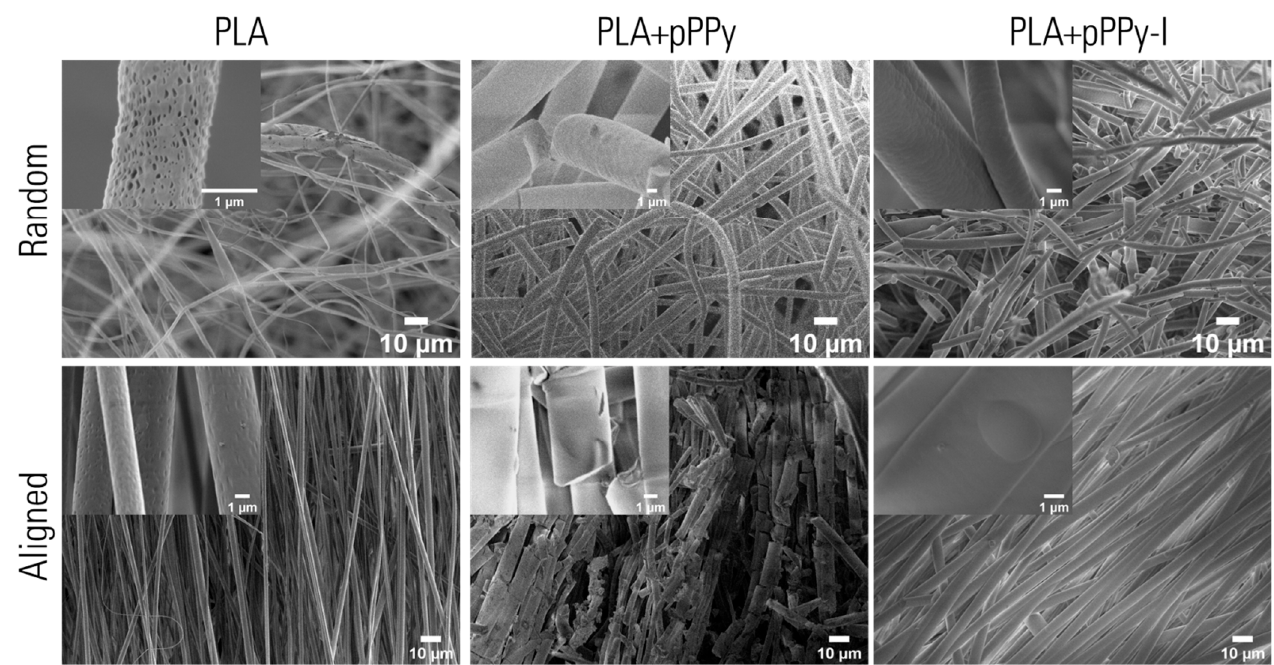
Figure 8. SEM images of fabricated scaffolds. Fiber microstructure shows a porous surface on PLA scaffolds whereas coated scaffolds have smooth surface fibers. Aligned scaffolds fibers display fibers oriented in a preferential direction, in contrast to randomly ‐ oriented fibers on random scaffolds.